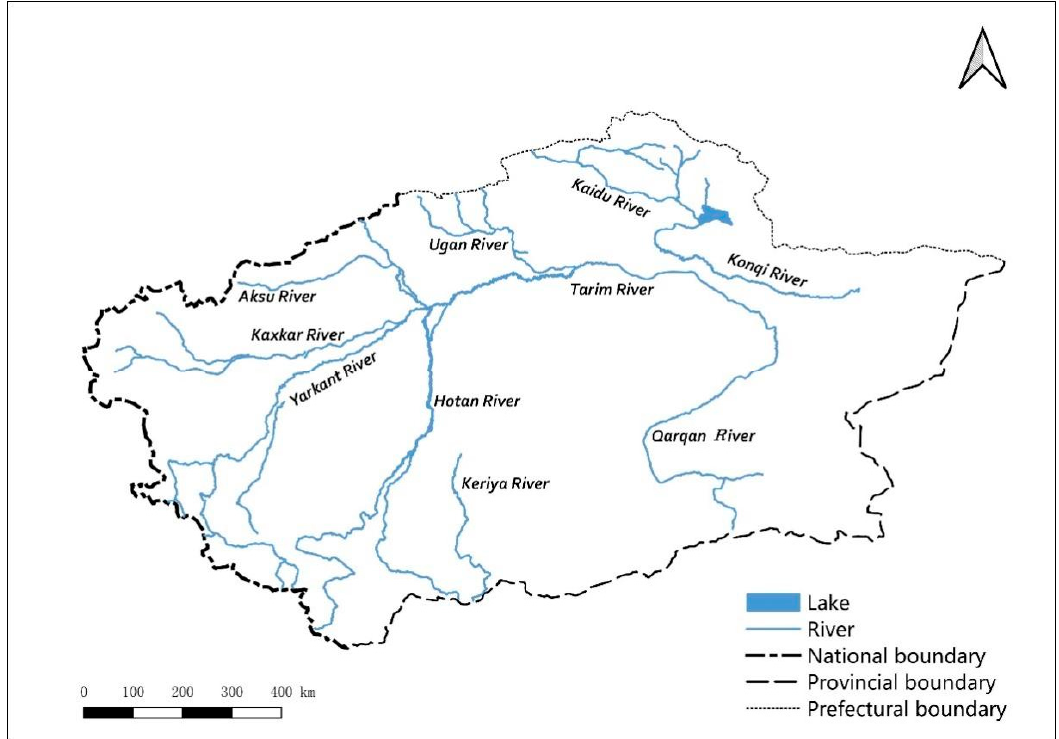
Figure 1. Tarim River Basin, Xingjiang, China.